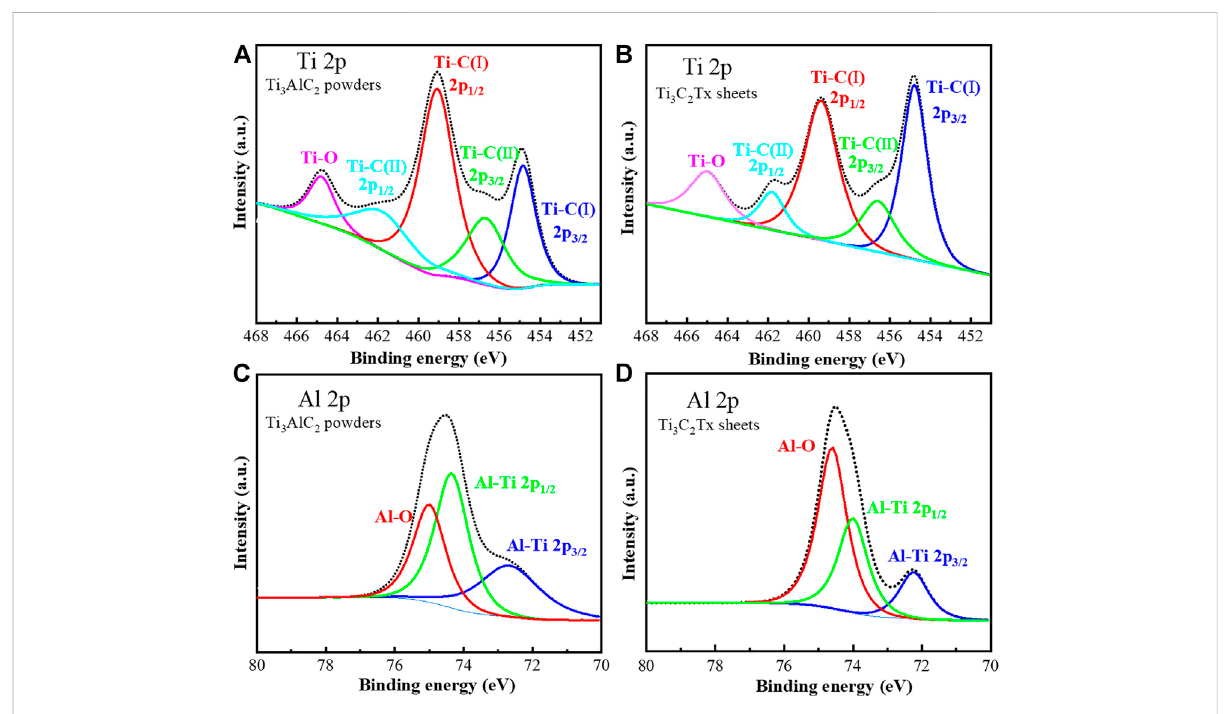
FIGURE 7 High-resolution XPS spectra of Ti 2p (A) and (B) and Al 2p (C) and (D) of Ti 3 AlC 2 powders and Ti 3 C 2 T x sheets, respectively.